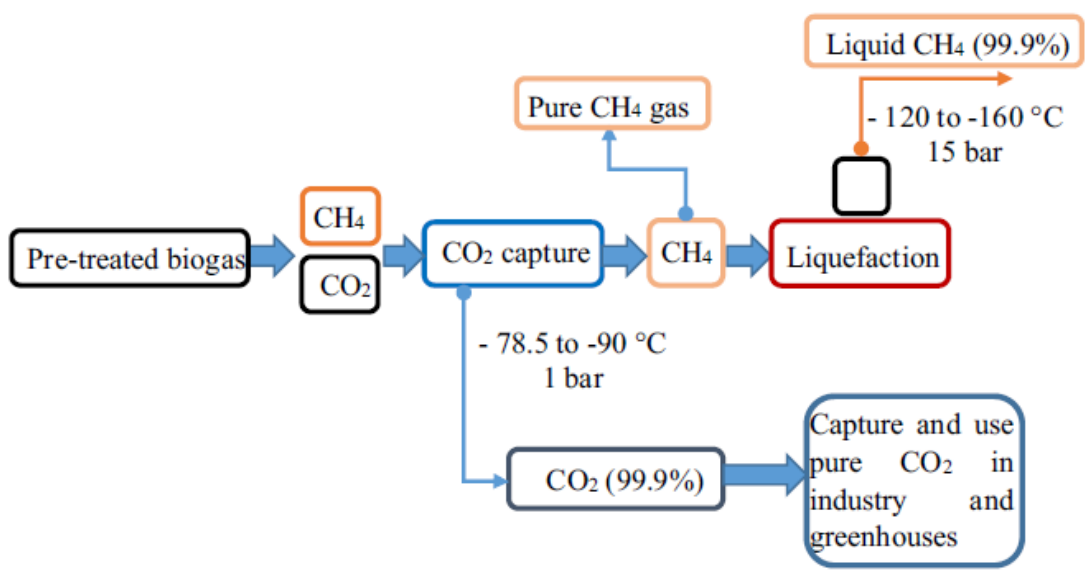
Figure 13. Flow diagram of the cryogenic process [93] .